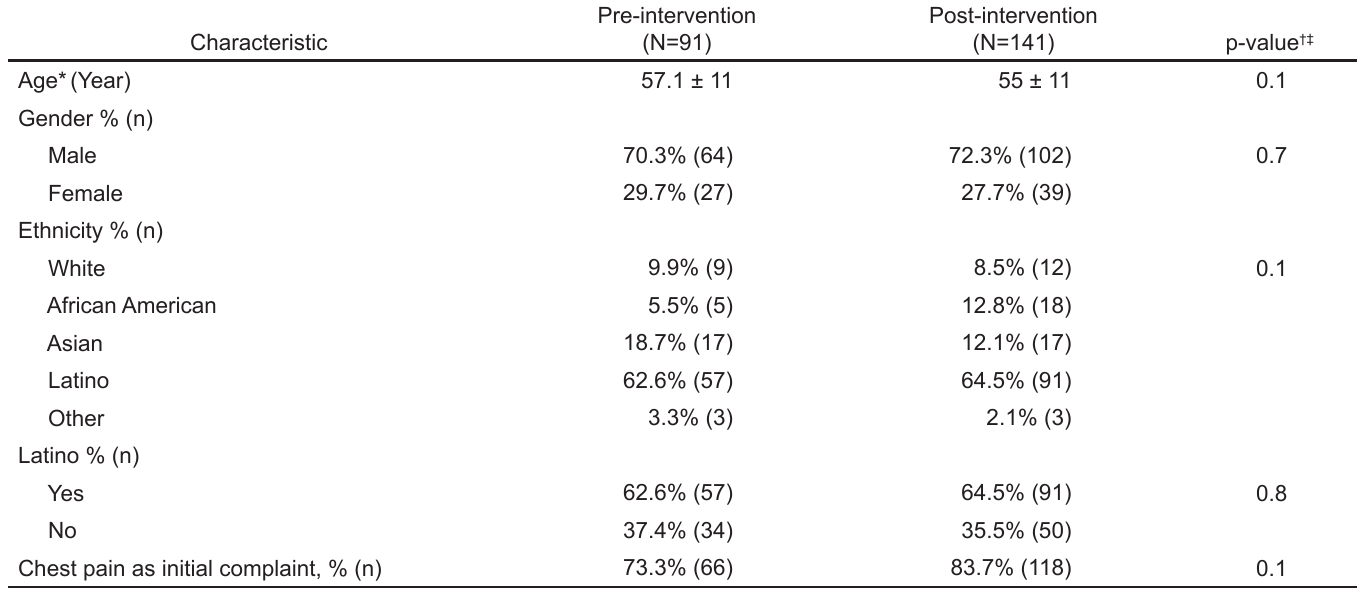
STEMI, ST segment elevation myocardial infarction *Mean ± SD. † Obtained from chi-square test except from Wilcoxon rank-sum test for